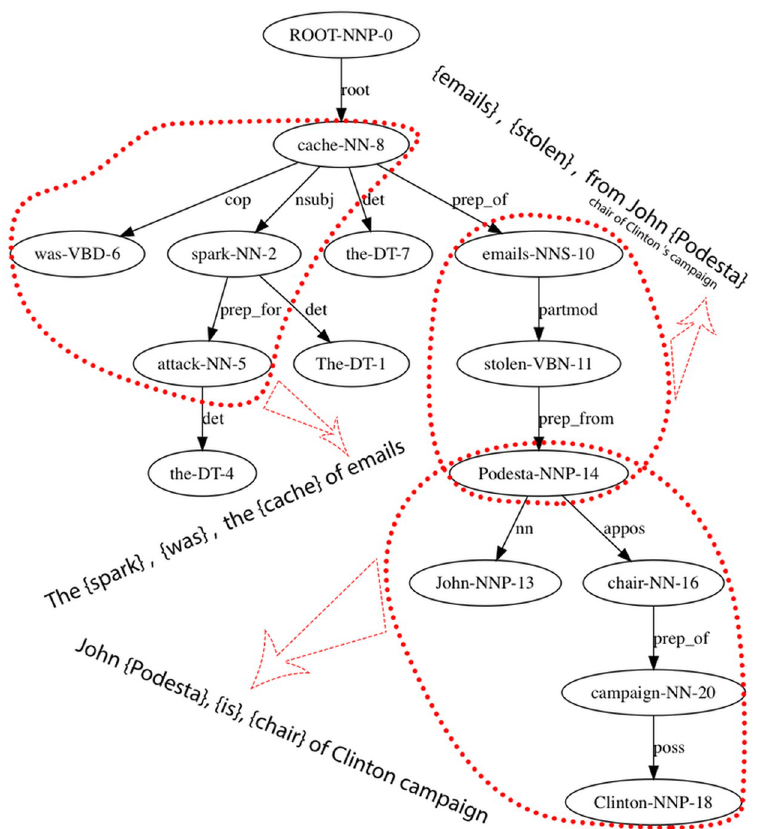
Fig 4. An example of syntax-based relationship extraction patterns. The sentence, “The spark for the attack was the cache of e-mails stolen from John Podesta, chair of Clinton’s campaign” is analyzed to extract three relationship triples. These relationships are then aggregated across the entire corpus to create the final narrative